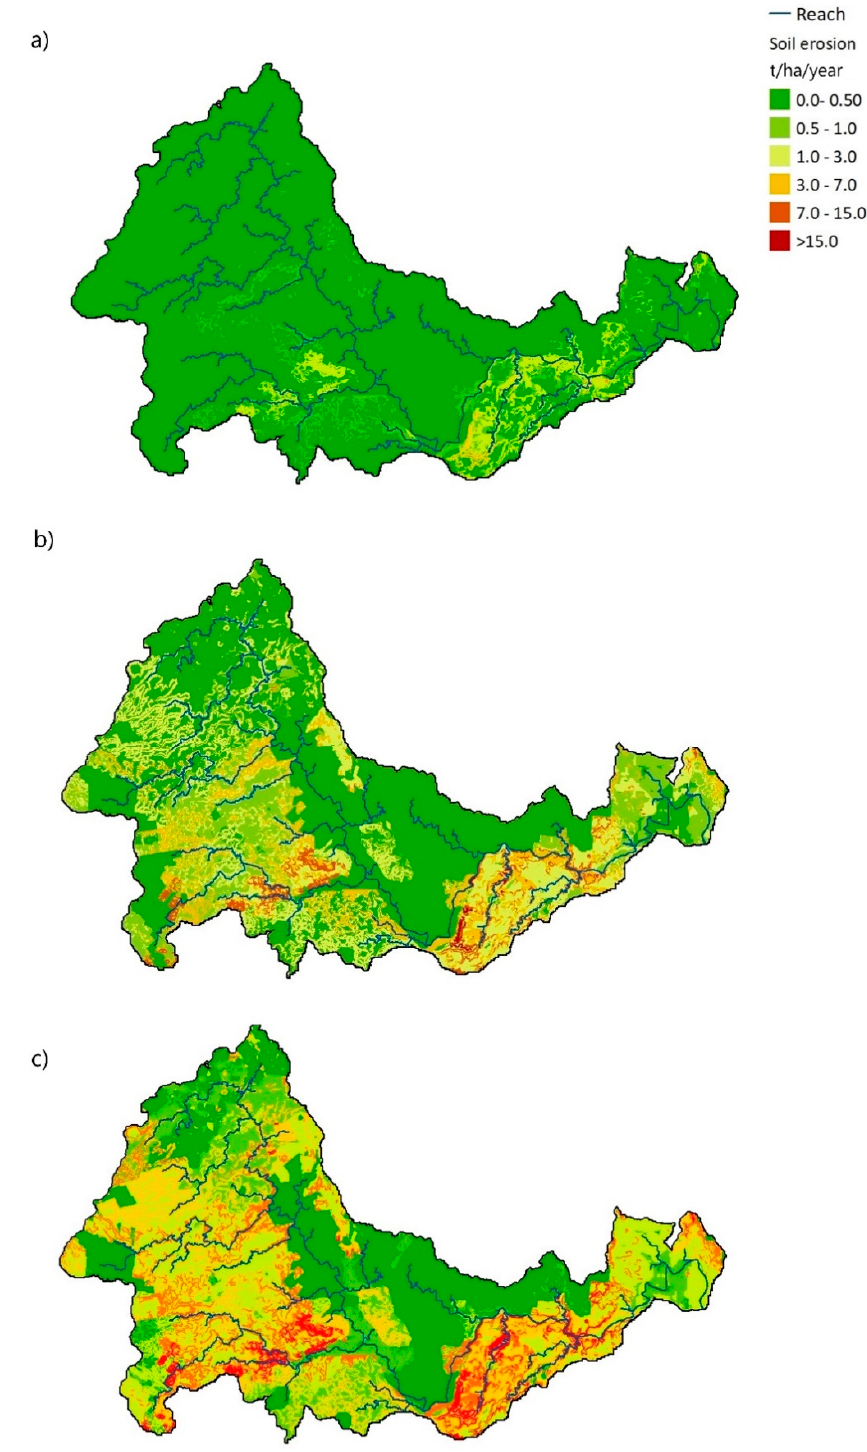
Figure 11. Spatial maps of ( a ) average simulated soil erosion for the extreme dry year (2002), ( b ) average simulated soil erosion of the simulation period (1991–2002), and ( c ) average simulated soil erosion for the extreme wet year (1999).